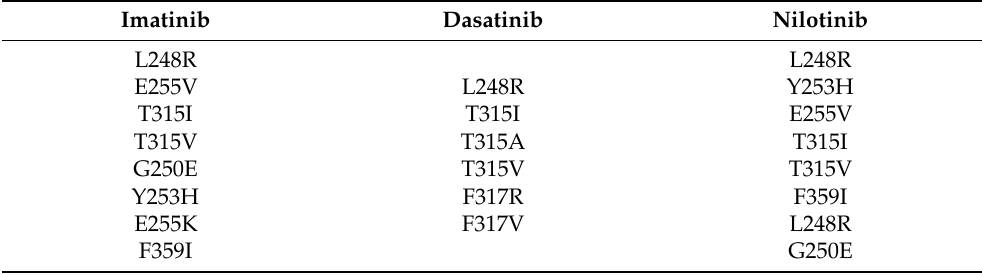
Table 6. Point mutation of BCR :: ABL1 gene found in cells with resistance to imatinib, dasatinib, and nilotinib. Imatinib Dasatinib Nilotinib